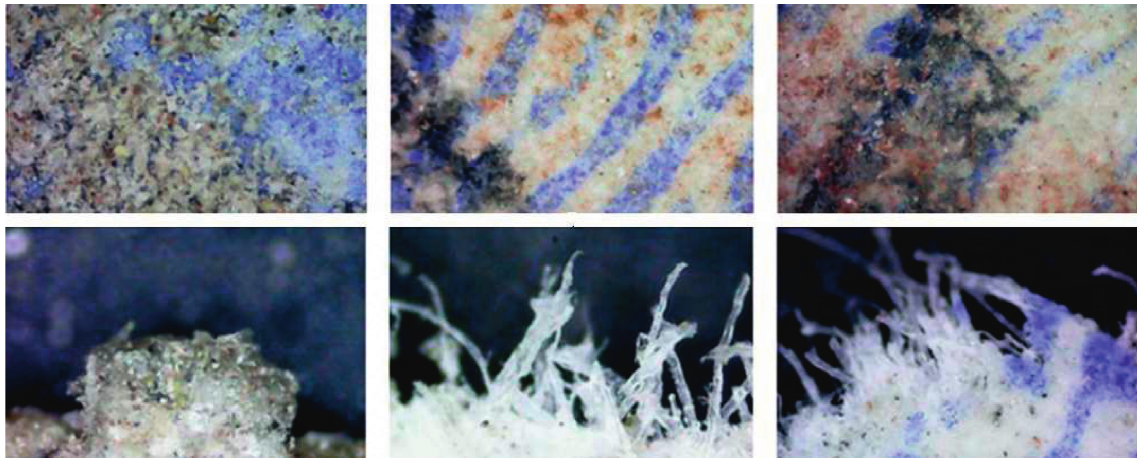
Figure 6: Various tears and spots on the blue stamp and the weakness of the outer part (serrated margins) at